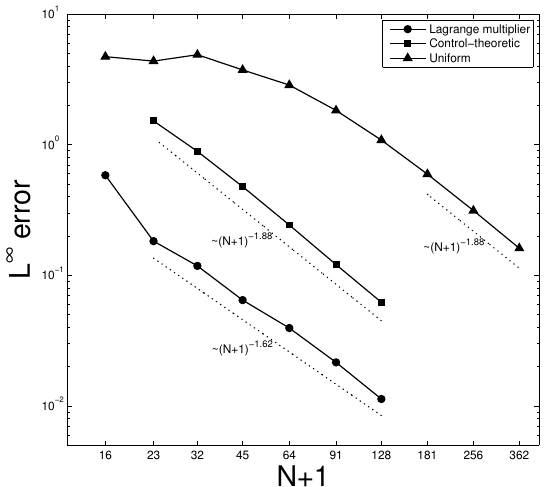
Figure 11. Comparison of the convergence rates of the discussed methods: Integration in time was performed using the 4th-order Lobatto IIIA–IIIB method for constrained systems in case of the Lagrange multiplier strategy and the 4th-order Gauss scheme in case of both the control-theoretic strategy and the uniform mesh simulation. The 4th-order Lobatto IIIA–IIIB scheme for the control-theoretic strategy and the uniform mesh simulation yield a very similar level of accuracy. Also, using 2nd-order integrators gives very similar error